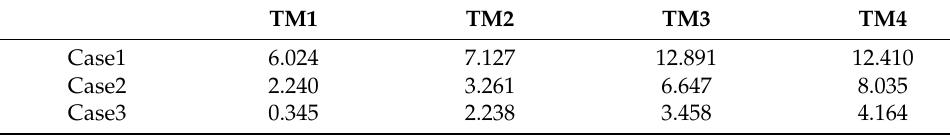
Table 4. NMAPE of estimated girder moment for each TM and case.